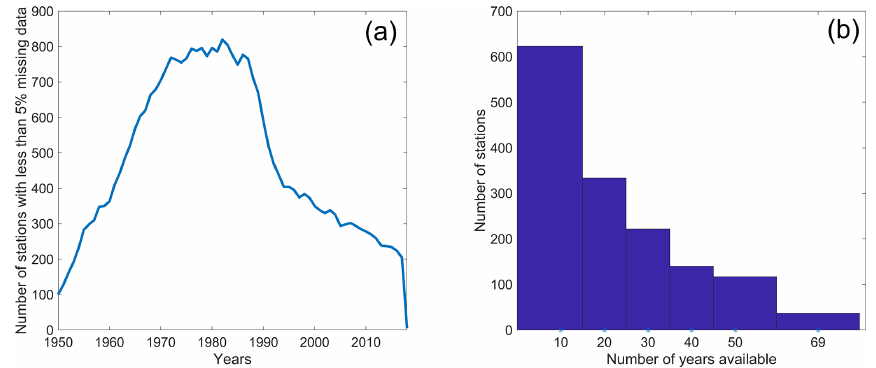
Figure 2. Number of available stations per year with less than 5% missing data (a) and number of stations available for different record lengths (b) .